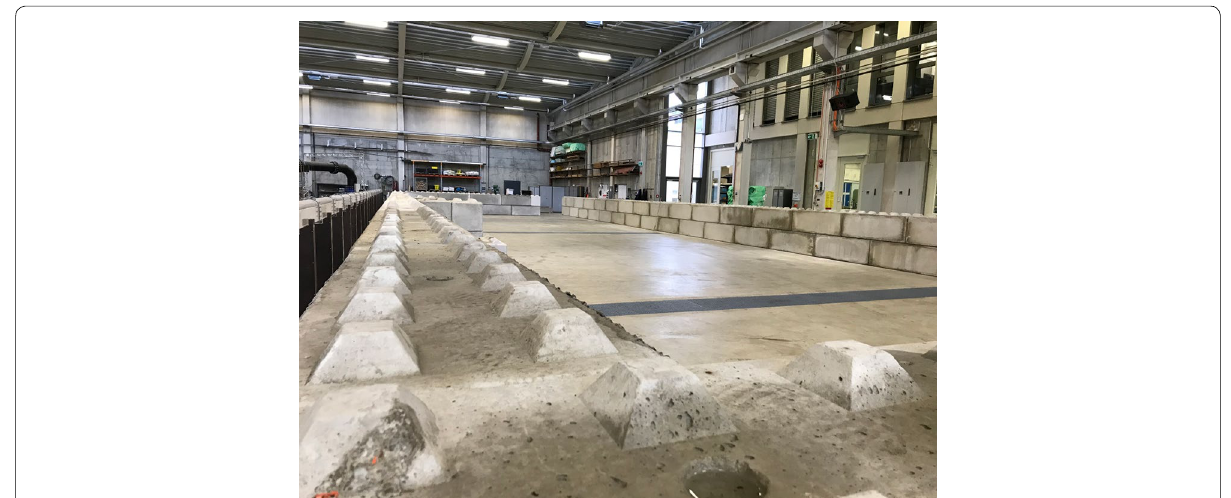
Fig. 2 Construction work on a physical model of Havel polder. A base frame with a length of 34 m and width of 11 m is set up with concrete build‑ ing blocks to form a basin; afterwards, a model dike with a breach will be constructed inside. Flooding this structure will give insight into the filling characteristics, so that constructional measures for an intended filling of the polder can be